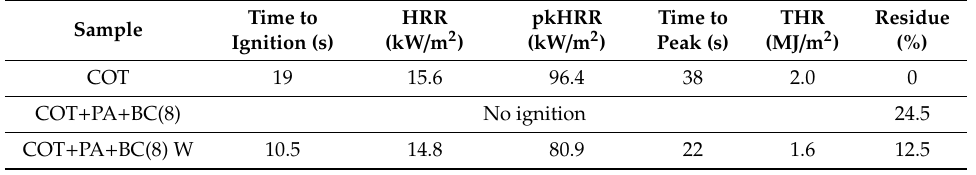
Table 7. Combustion data for untreated and treated cotton fabrics after washing (heat flux: 35 kW / m 2 ).